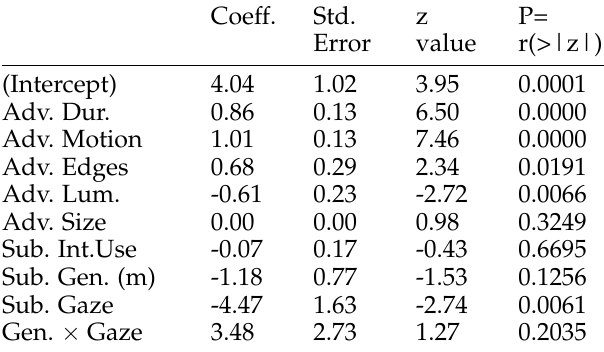
Effects of advert saliency and individual factors on